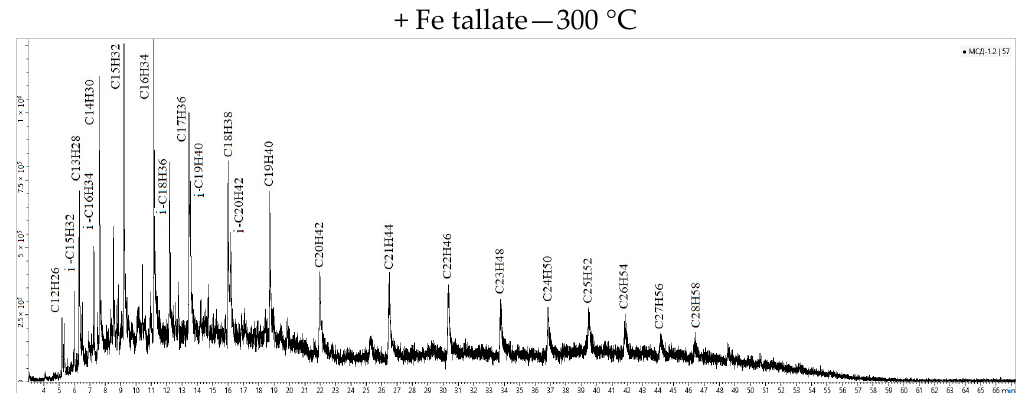
Figure 12. Mass-fragmentograms of alkanes ( m/z = 57) from the saturated fraction. Figure 13 shows GC-MS spectra of aromatic hydrocarbons of the original bitumoid and bitumoids after TST at different temperatures and the presence of iron thallate by total ionic current (TIC).